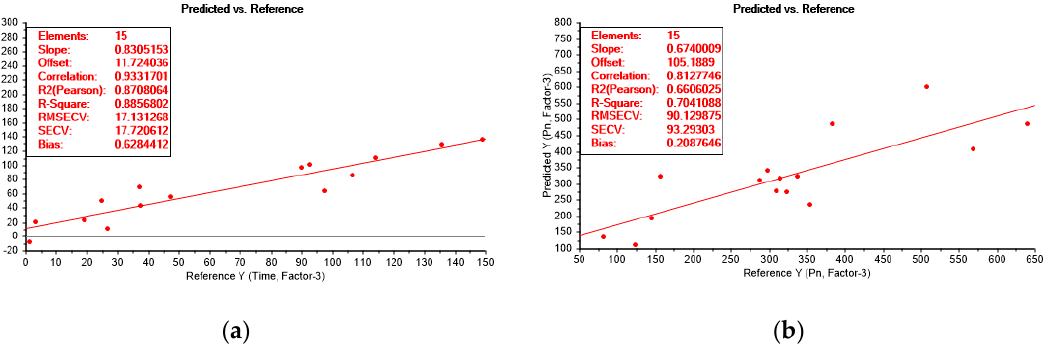
Figure 13. Prediction of filtration duration ( a ) and membrane permeability ( b ).